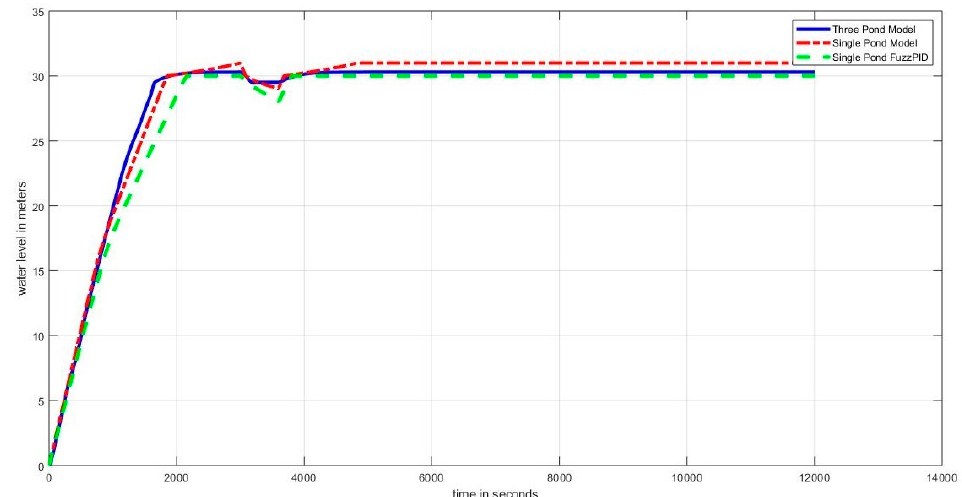
Figure 30. Traditional system vs. the proposed system (half) (positive surge, steady state).